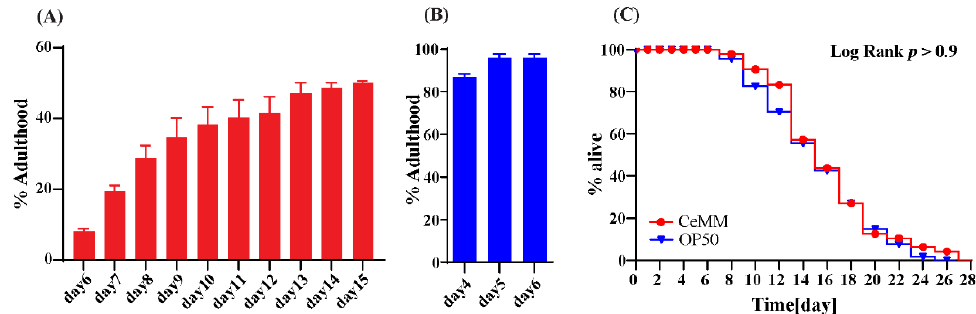
Figure 1. CeMM diet attenuates the development of L. marina but does not promote its longevity. ( A ) For 15‰ sea salt CeMM developmental analysis, 70 newly hatched L1s were transferred onto each indicated 3 cm dimeter agar plates of 15‰ sea salt CeMM (three trials, n = 70 worms in each trial). All data shown here are mean ± SEM (standard error of mean). ( B ) For OP50 developmental analysis, 70 newly hatched L1s were transferred onto each indicated 3 cm dimeter agar SW-NGM with E. coli OP50 (three trials, n = 70 worms in each trial). All data shown here are mean ± SEM. ( C ) For lifespan assay (one trial, n = 96, and 115 for OP50 and CeMM feeding, respectively), L4 females were transferred to each assay plate and incubated at 20 °C. The number of live and dead worms was counted every day. Live worms were assigned to 3 cm dimeter agar plates (15‰ sea salt CeMM plates and SW-NGM plates with fresh OP50) every two days.